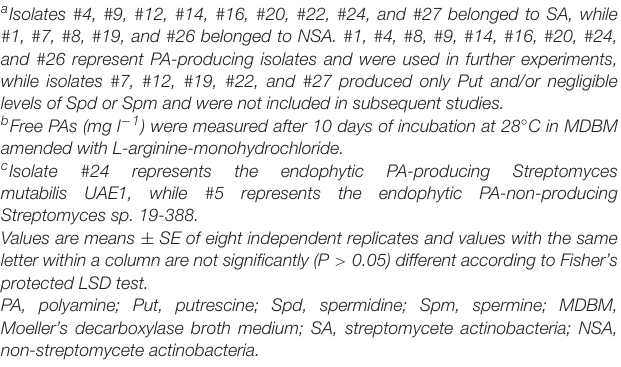
protected LSD test. PA, polyamine; Put, putrescine; Spd, spermidine; Spm, spermine; MDBM, Moeller’s decarboxylase broth medium; SA, streptomycete actinobacteria; NSA, non-streptomycete